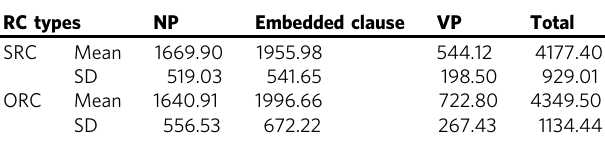
Table 4 Mean reading times and standard deviation for SRC and ORC for the entire sentence and different regions (ms).